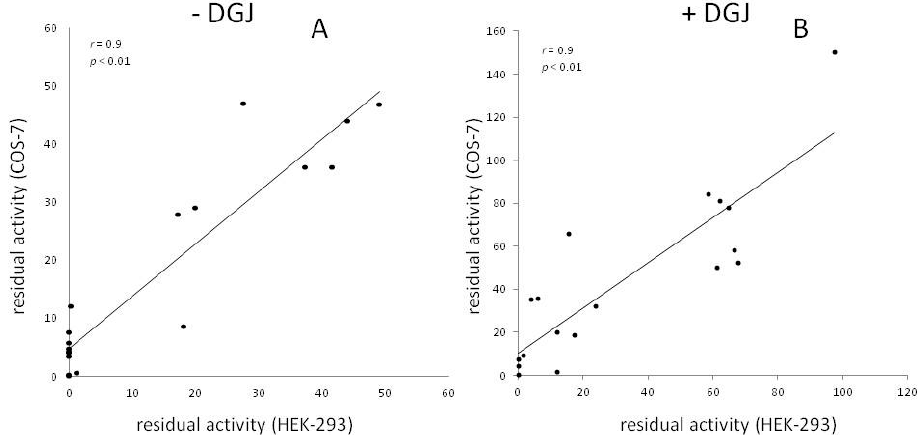
Figure 1. The residual activity of mutants transiently transfected and expressed in COS7 and in HEK293 is shown. In the case that multiple reports are available for a given mutant and a given recipient cell type, the average value was plotted. Results in the absence of DGJ ( A ) or in the presence of DGJ ( B ) are reported.